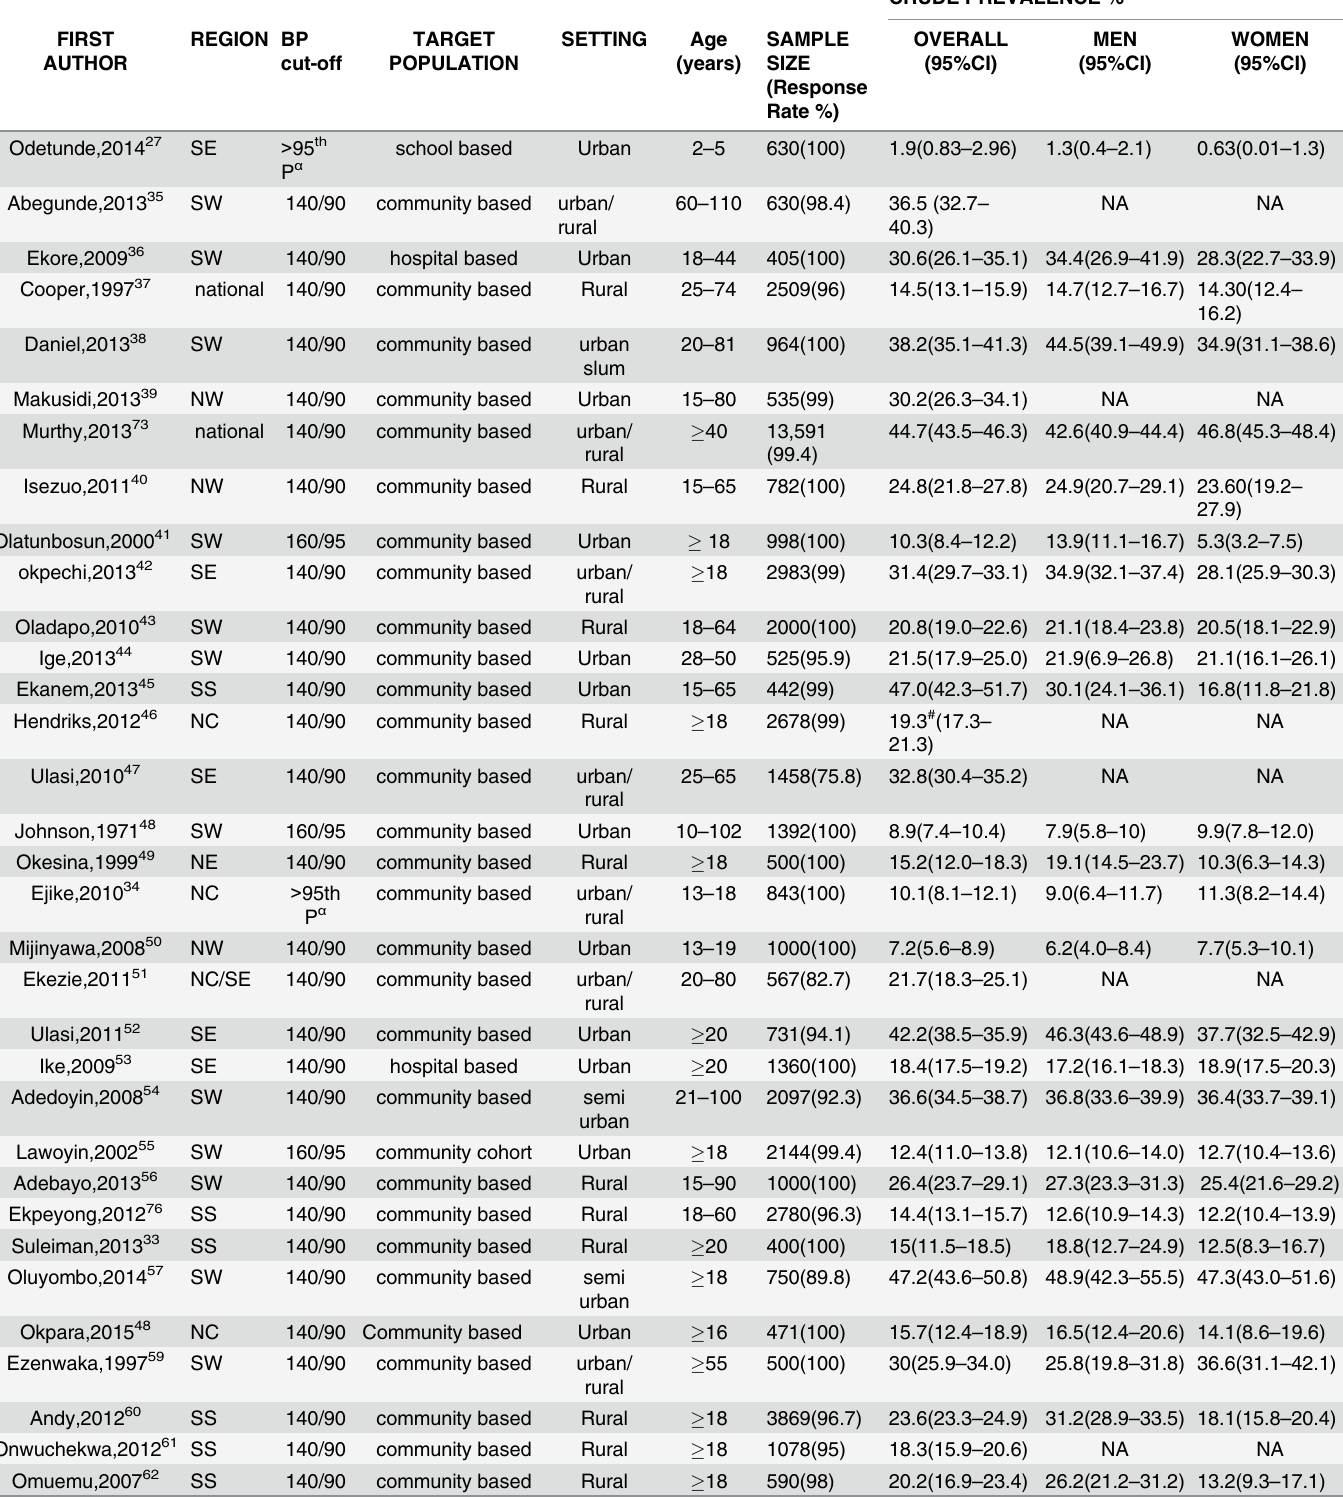
Table 1. Characteristics of all studies included in the systematic